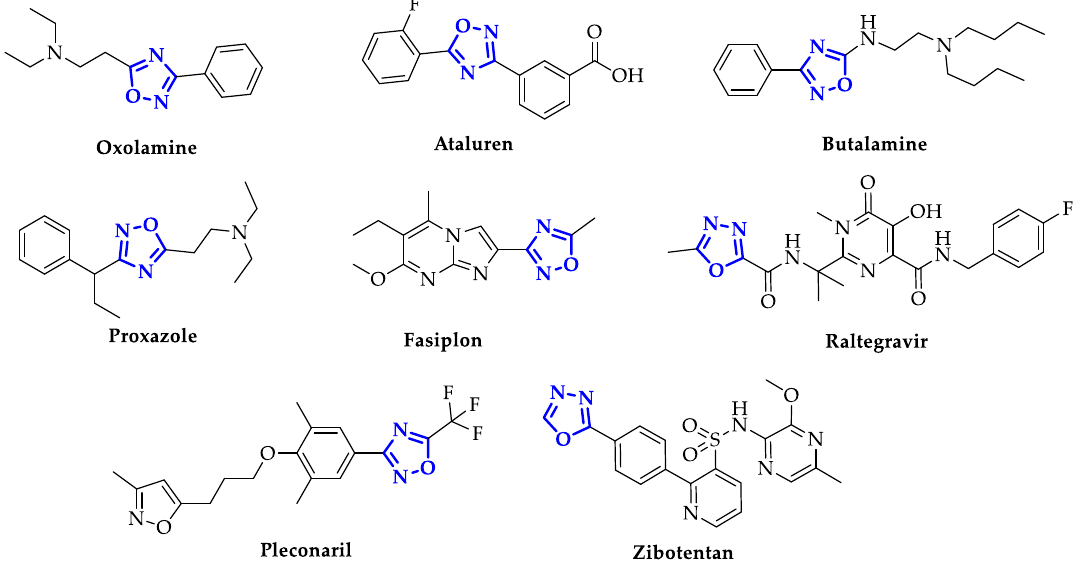
Figure 2. Structures of some of the most famous ligands bearing oxadiazole moiety.